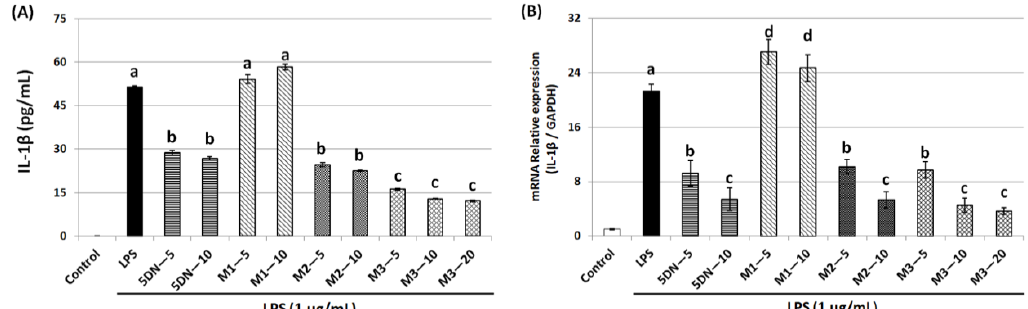
Figure 4. Inhibitory effects of 5DN and its metabolites M1, M2, and M3 on LPS-induced IL-1 β expression in RAW 264.7 cells at protein ( A ) and mRNA ( B ) levels. Results are presented as mean ± SD. Different superscript letters in each column indicate significant differences between groups ( p < 0.05, n = 3) by one-way ANOVA and Tukey’s post hoc test.